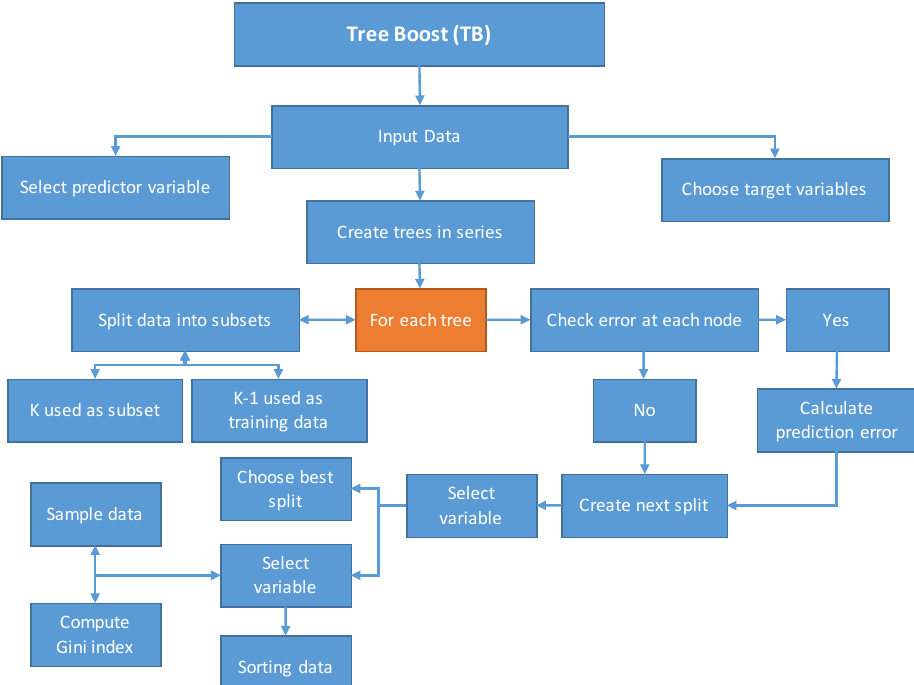
Figure 4. Tree boost (TB) flow chart (reproduced form Raza et al. [37]).